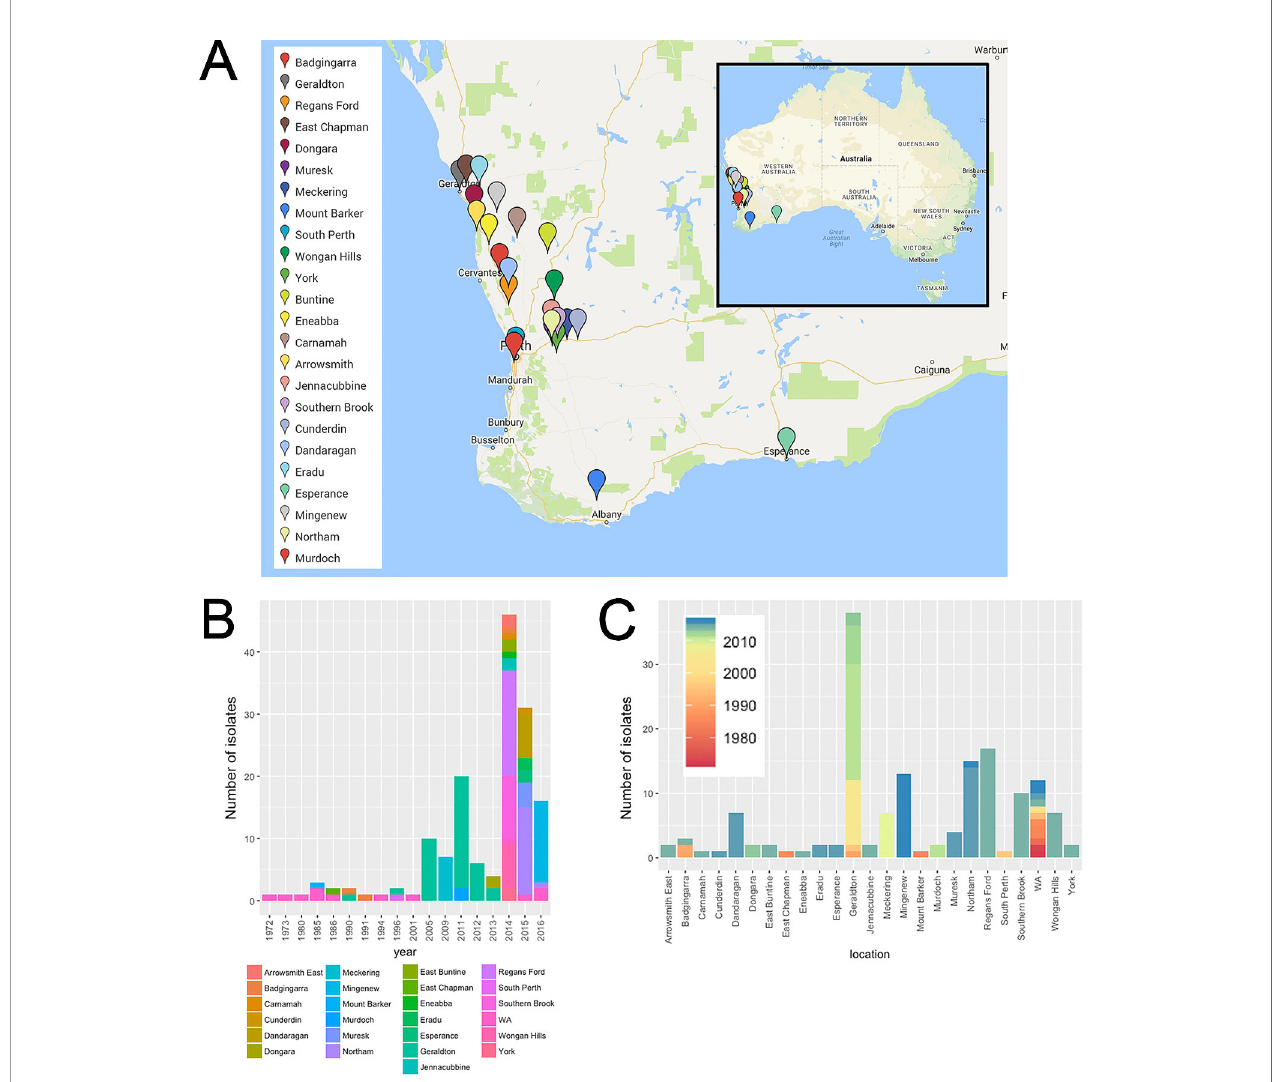
FIGURE 1 | Spatial-longitudinal distribution of Australian P. nodorum isolates collected between 1972-2016: (A) Sampling sites (Google Maps, CA, USA) isolates with unknown collection location in WA were designated as “ WA ” and were not included in the map; (B) number of isolates per sampling year; (C) per sampling